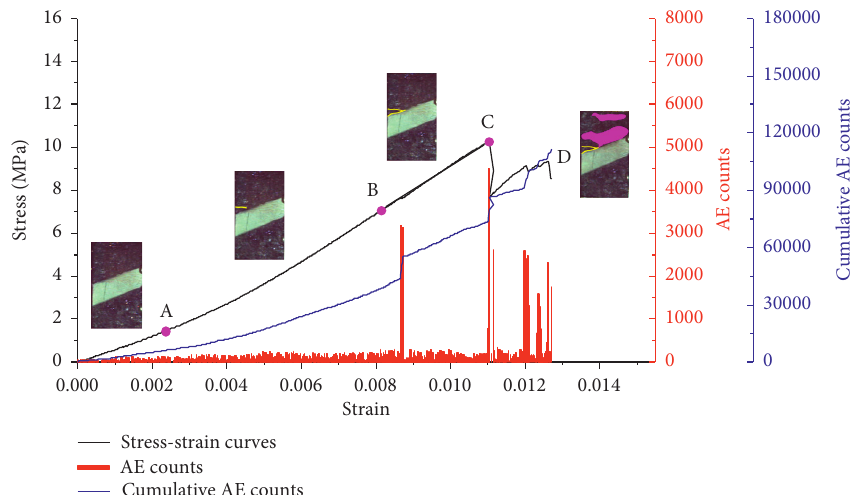
Figure 6: Stress-strain curve and acoustic emission monitoring curve of composite specimens with a 30 ° dip angle